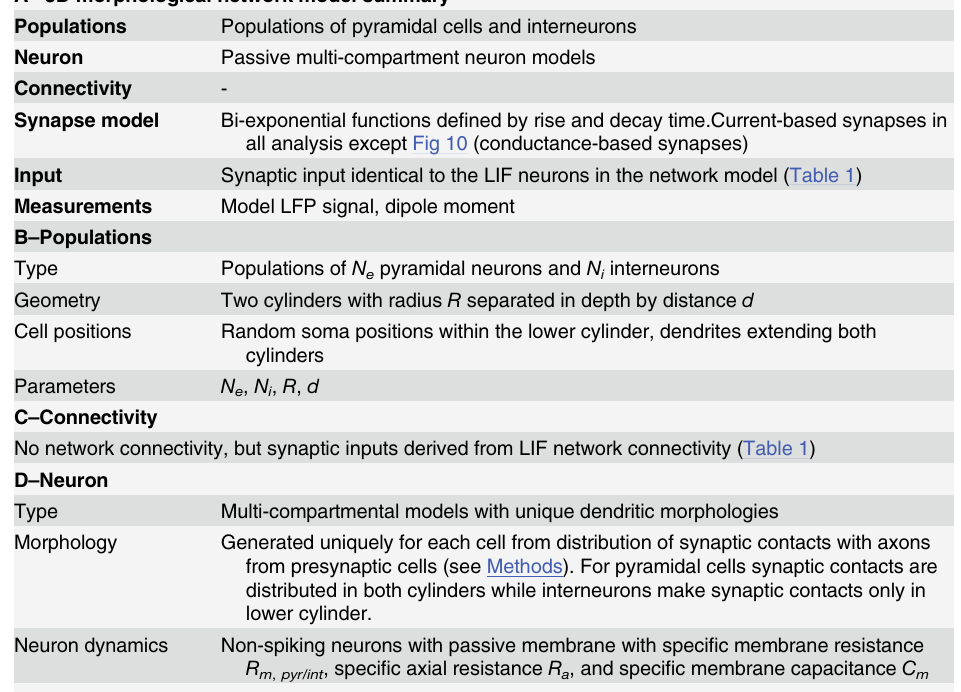
Table 3. Summary of 3D network model of multi-compartmental neurons. A – 3D morphological network model